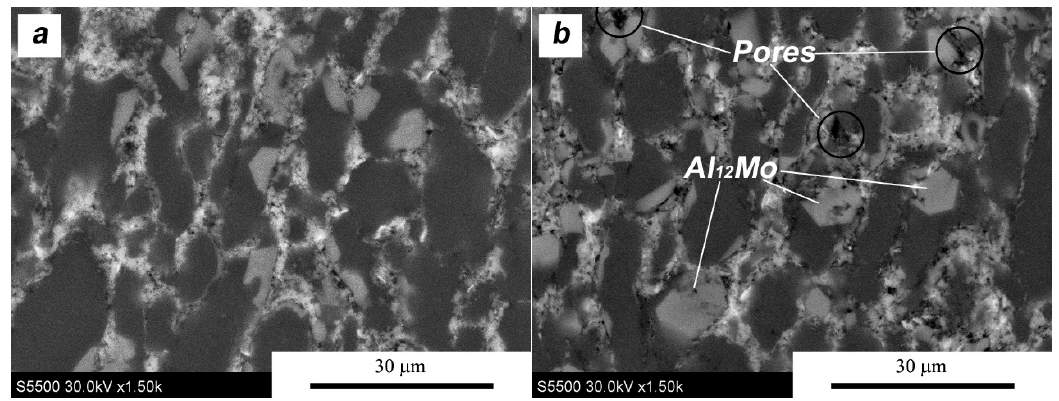
Figure 17. Microstructure of AA6061/MoS 2 10 vol % SPT samples’ center areas (BSE SEM images): ( a ) λ = 1.5; ( b ) λ = 2.